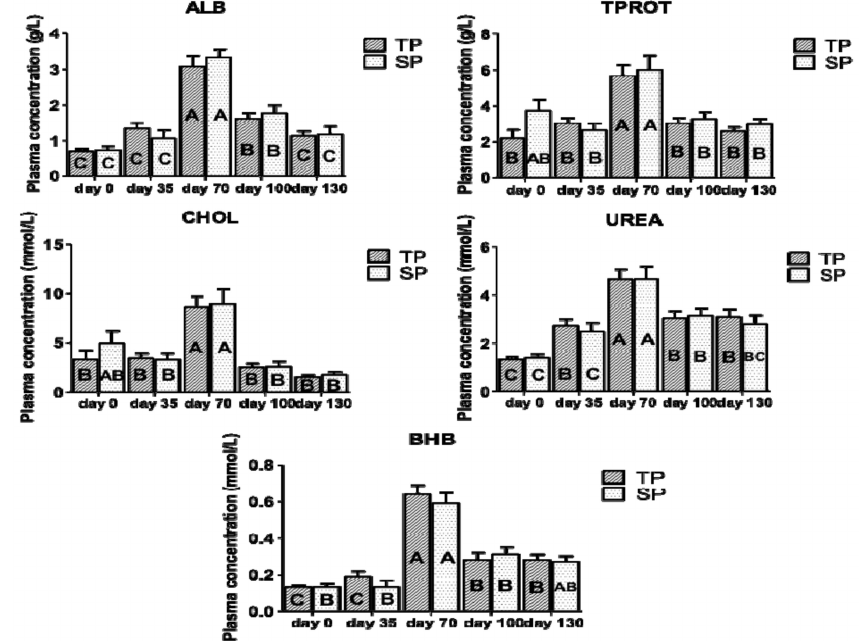
Figure 4. Metabolic response (ALB, TPROT, CHOL, urea and BHB) of lambs from twin- and single bearing ewes according to time (LSM ± SEM). TP: twin-bearing ewes (n = 6); SP: single-bearing ewes (n = 7); ALB: albumin; TPROT: total protein; CHOL: cholesterol; BHB: β -hidroxybutirate; day 0: birth, day 35: day 35 post-partum; day 70: day 70 post-partum (weaning); day 100: 30 days after weaning and day 130: 60 days after weaning; di ff erent capital letters (A, B, C) denote significant di ff erences of each group according to time p ≤